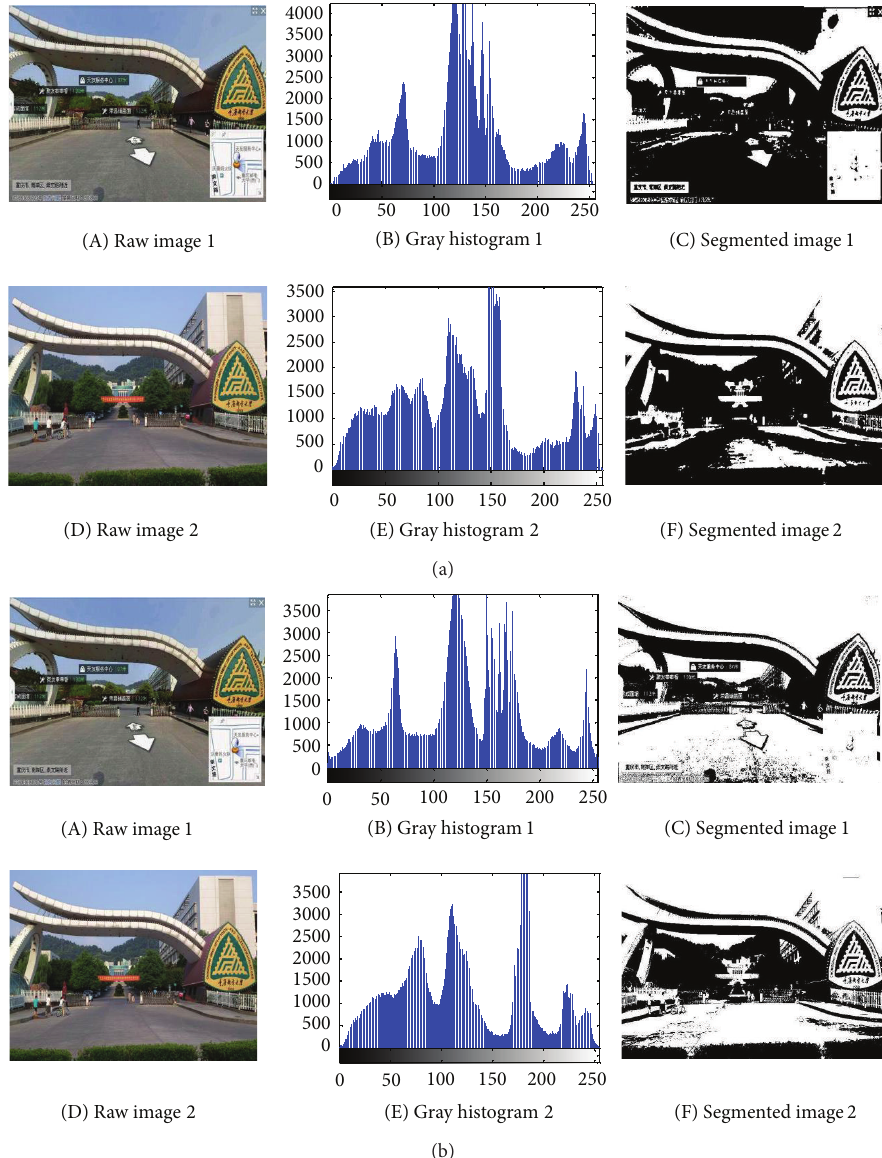
Figure 5: (a) Otsu segmentation on images in group 4. (b) 2DMETS on images in group